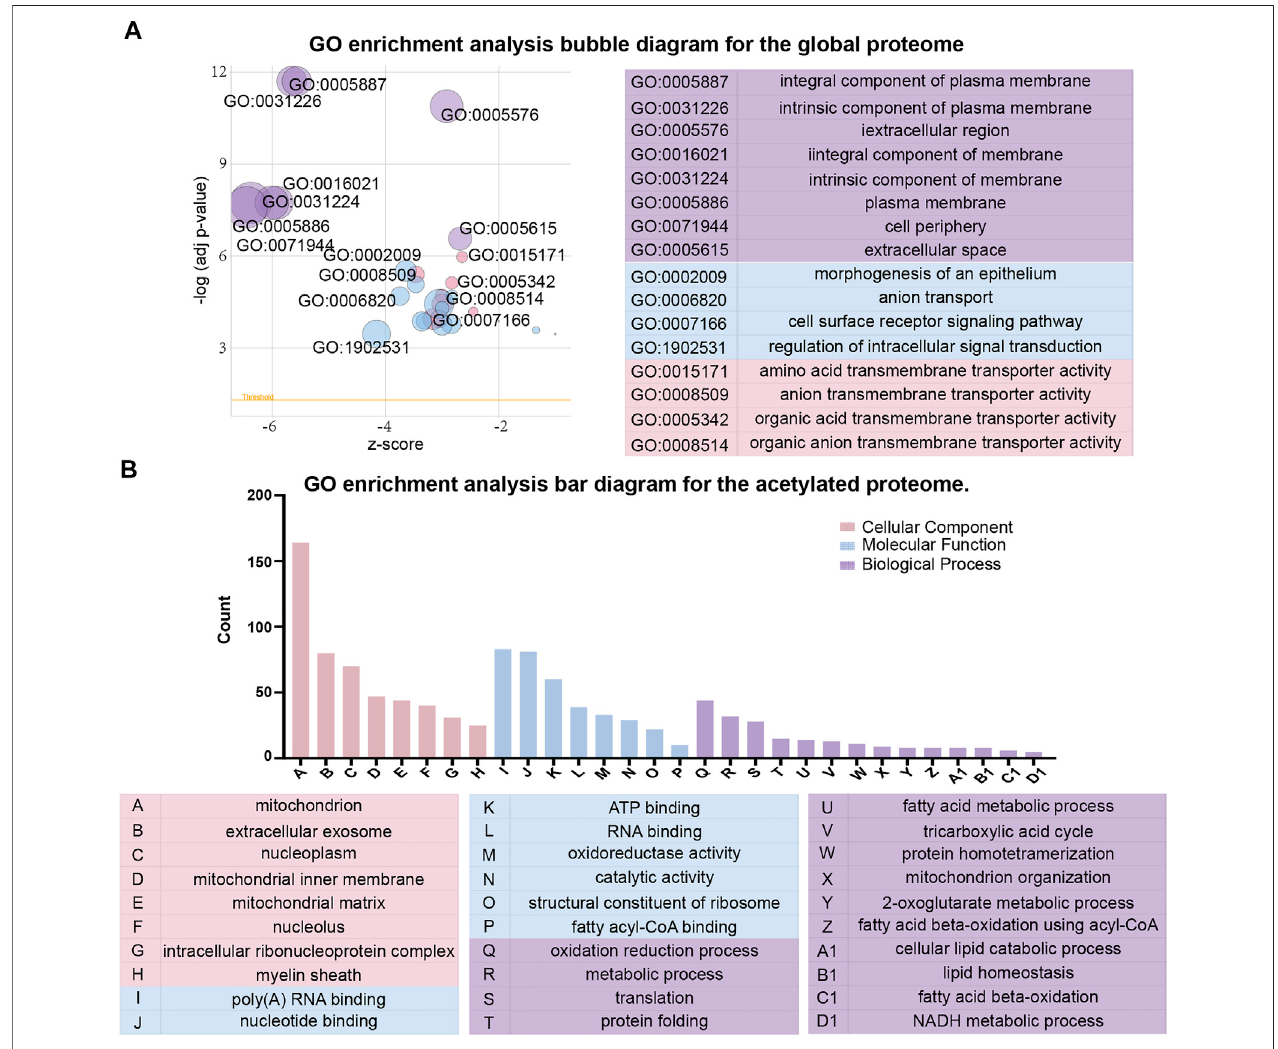
FIGURE 3 | Gene ontology (GO) functional classi fi cation of differentially expressed proteins between the global proteome and acetylated proteome. (A) GO enrichment analysis bubble diagram for the global proteome. (B) GO enrichment analysis bar diagram for the acetylated proteome.